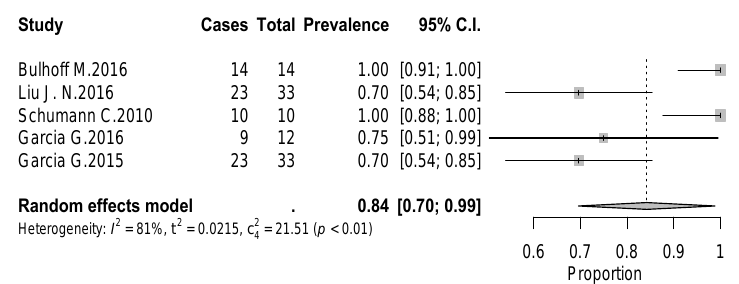
Figure 5. Forest plot chart of the rate of return to swimming after shoulder arthroplasty with 95% confidence interval .